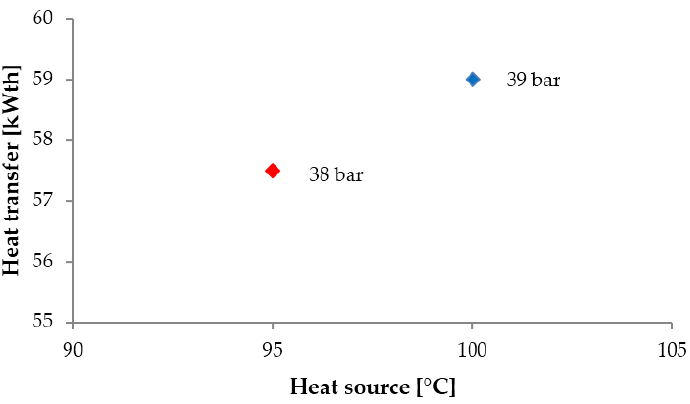
Figure 7. Heat transfer at constant mass flow of 0.3 kg/s and heat source temperature of 95 °C and 100 °C.